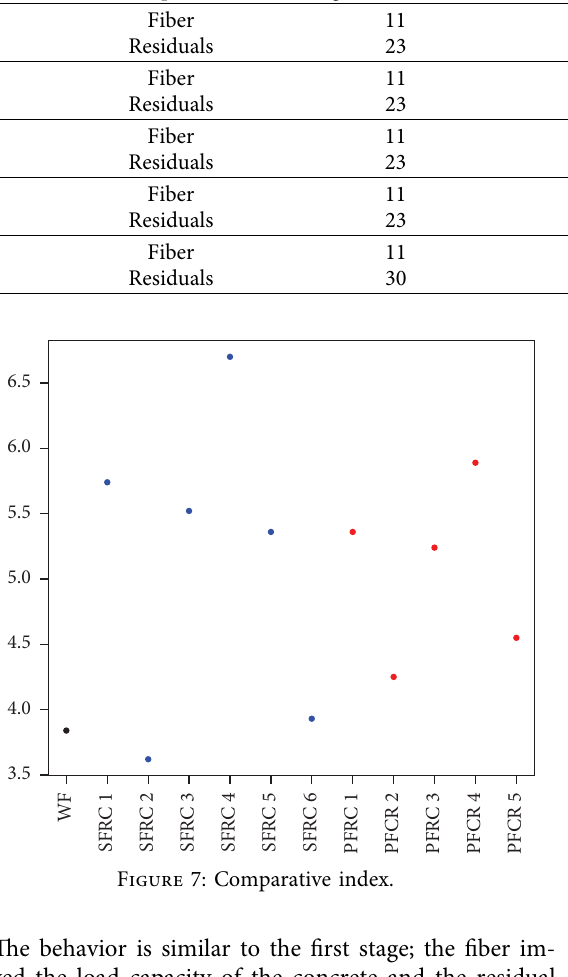
(6.9 kg/m 3 , slab 2), and the dosage with the highest per- formance was EUCLID fber with a dosage of 4.6 kg/m 3 (slab 8); both cases were tested on the same type of soil. In the case of the DRAMIX fber, the lower dosage (40 kg/m 3 ) had a